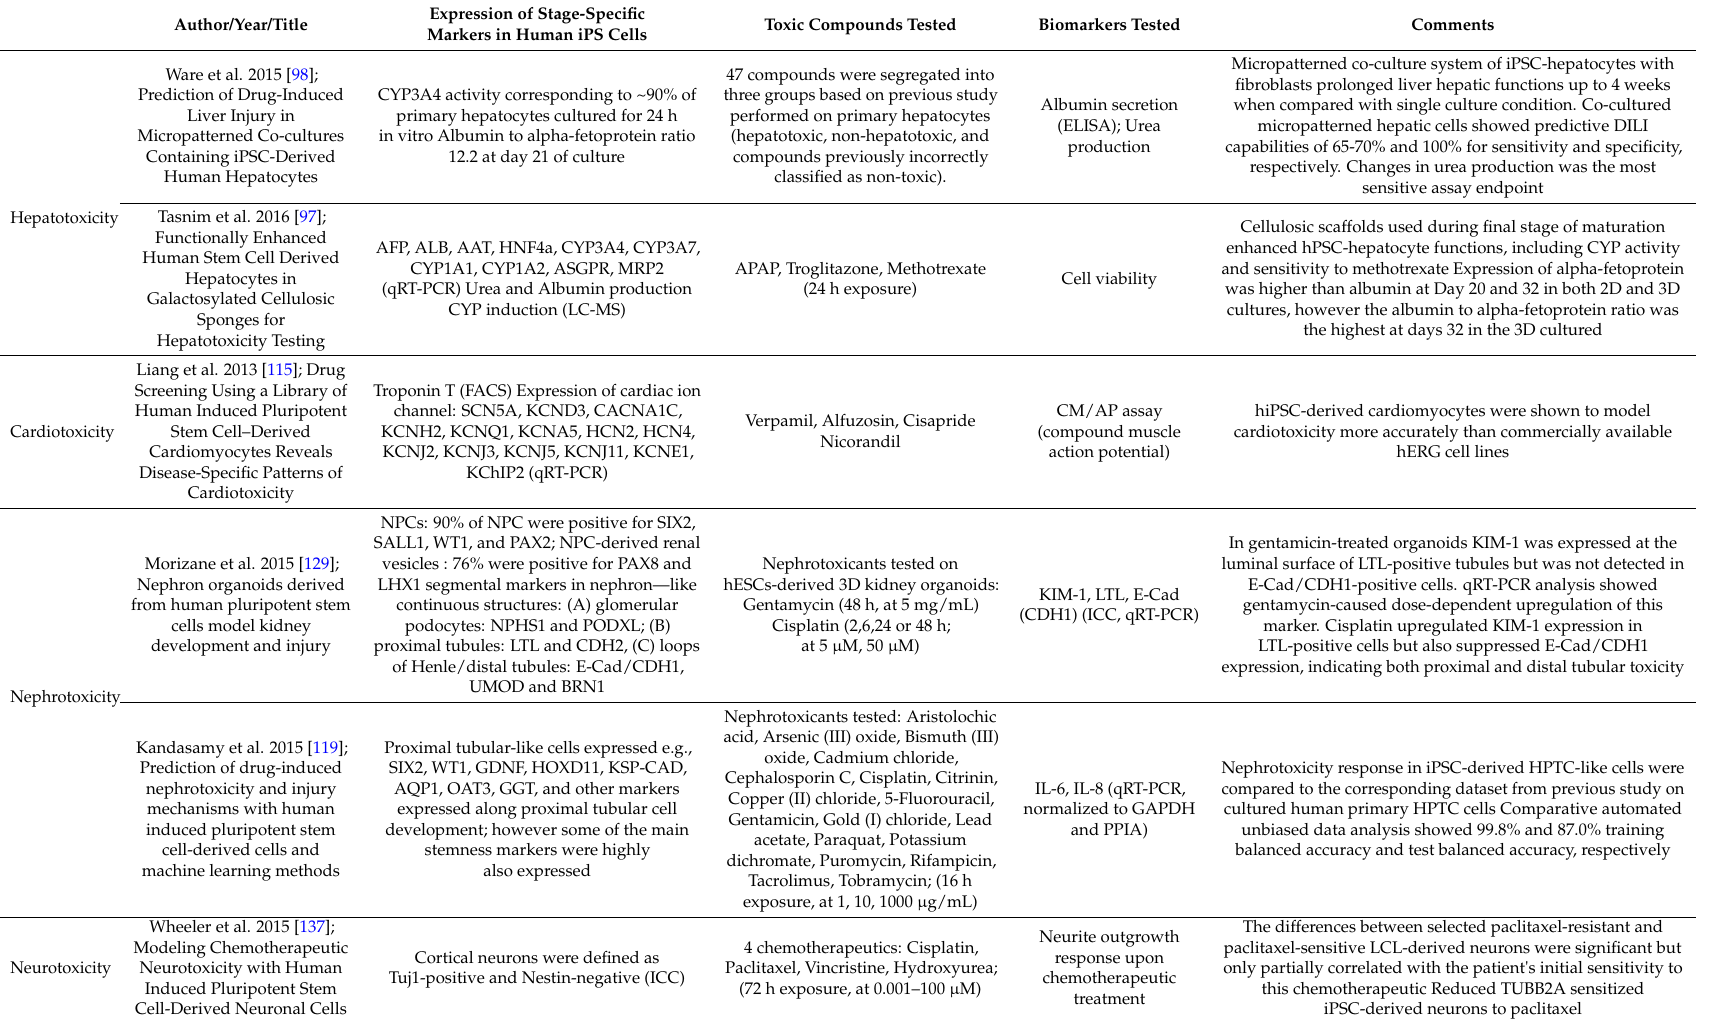
Table 1. Human iPSC-derived cells as an in vitro screening platform for detection of drug-induced